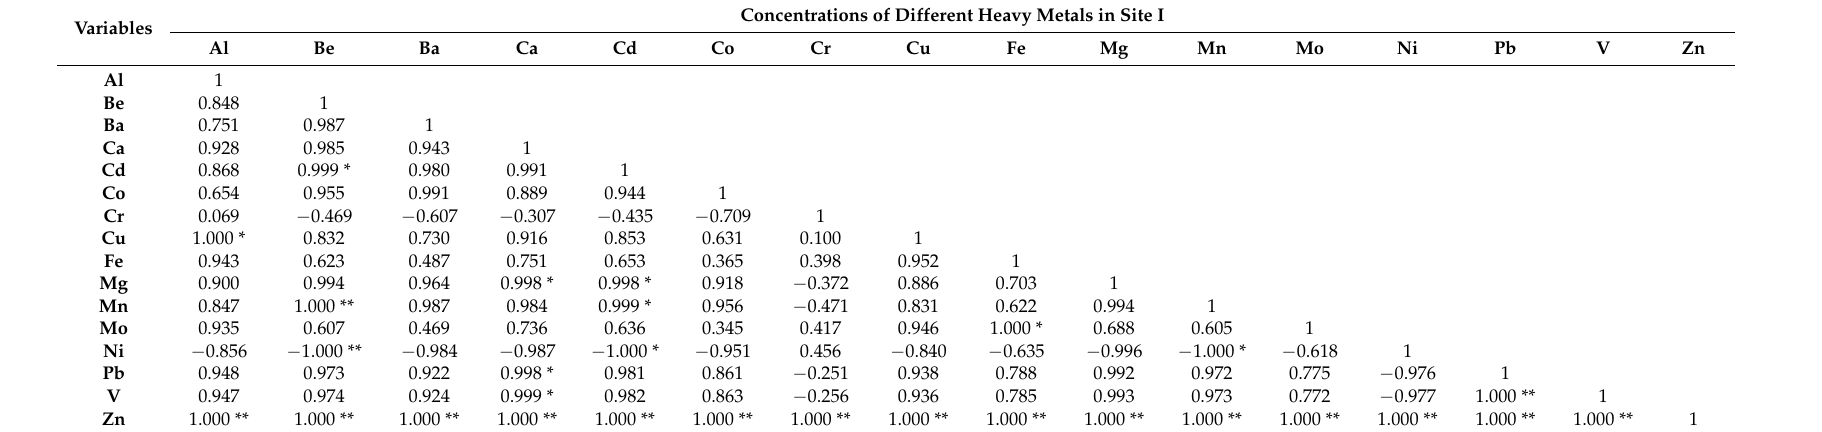
Table 7. Correlation between the concentrations of heavy metals in A. ochraceus of Site I (Riyadh). Concentrations of Different Heavy Metals in Site I Variables